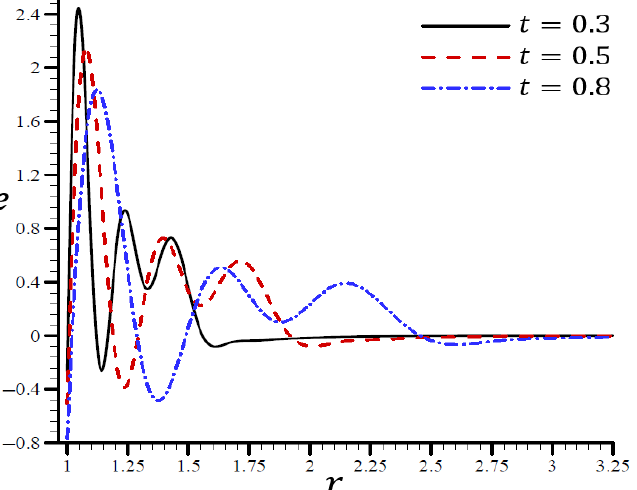
Figure 8. The influence of 𝑡 on volumetric strain 𝑒 through the radial direction of the spherical hole using the RTPL model.